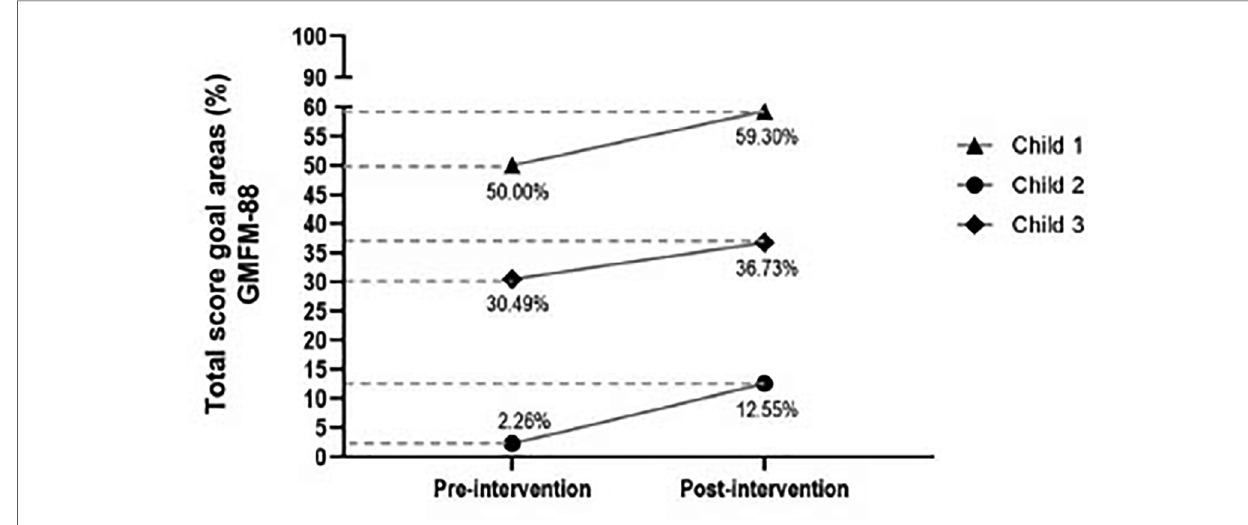
FIGURE 1 Changes in GMFM-88 percentage scores in the goal areas of the three children with CP of the Brazilian case series study during the 7 weeks of Family- Centered Care intervention (led by a COPCA coach). Figure reprinted from reference 38 with permission of Revista Fisioterapia em Movimento (Curibita, PR, Brazil: DOAJ).